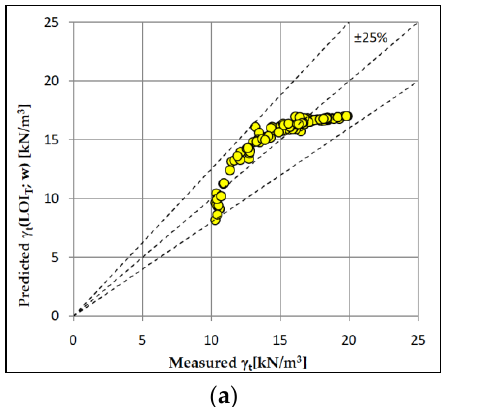
Table 2. Relative error (RE) of the evaluated soil unit weight of organic soil for use in single and two-factor